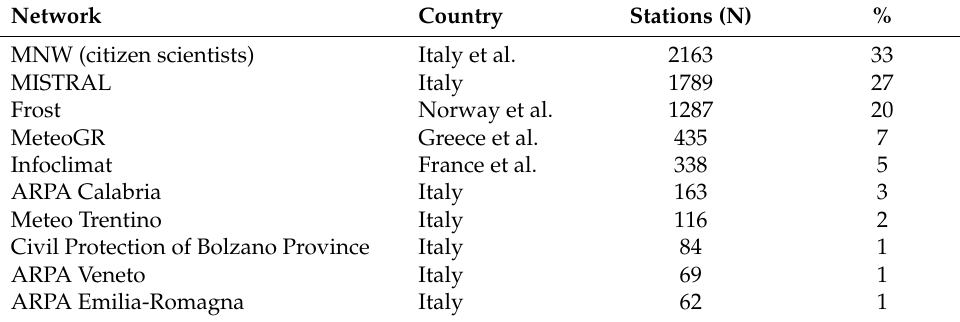
Table 2. Number of weather stations included in the MNW database and their relative percentage out of the total. The country column refers to the origin of the network owner; however, some weather stations are located outside the origin nation, hence, the term “et al.” can be here interpreted as “and other countries”.